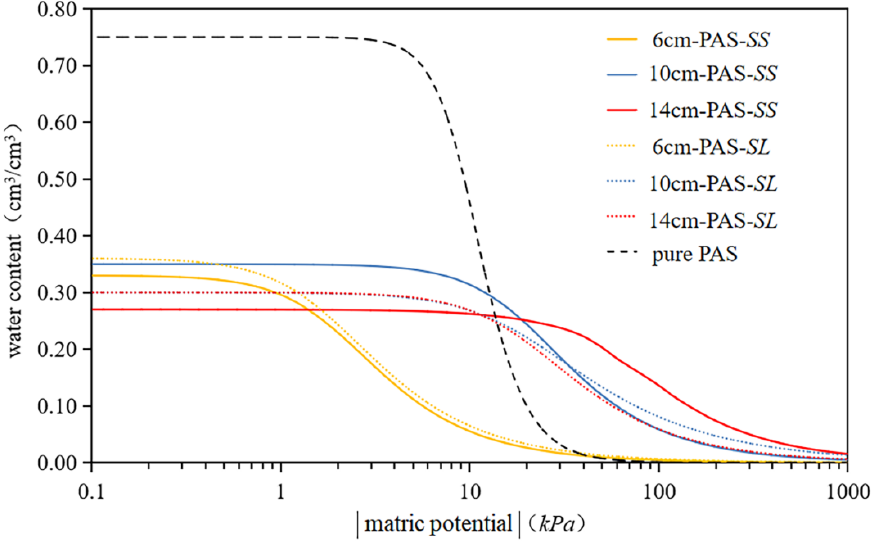
Figure 6. Water retention curves of PAS (preferential flow domain).